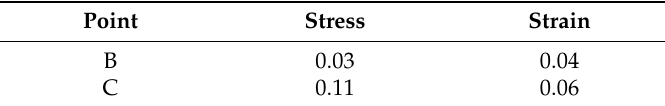
Table 8. AAE values of the proposed